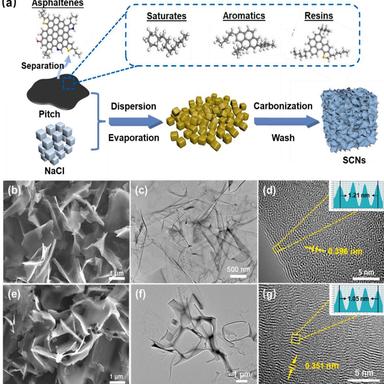
a) Schematic illustration of the preparation of SCNs. b) SEM, c) TEM, and d) HRTEM images of SCNs. e) SEM, f) TEM, and g) HRTEM images of SCNs-A. (A colour version of this figure can be viewed online.)